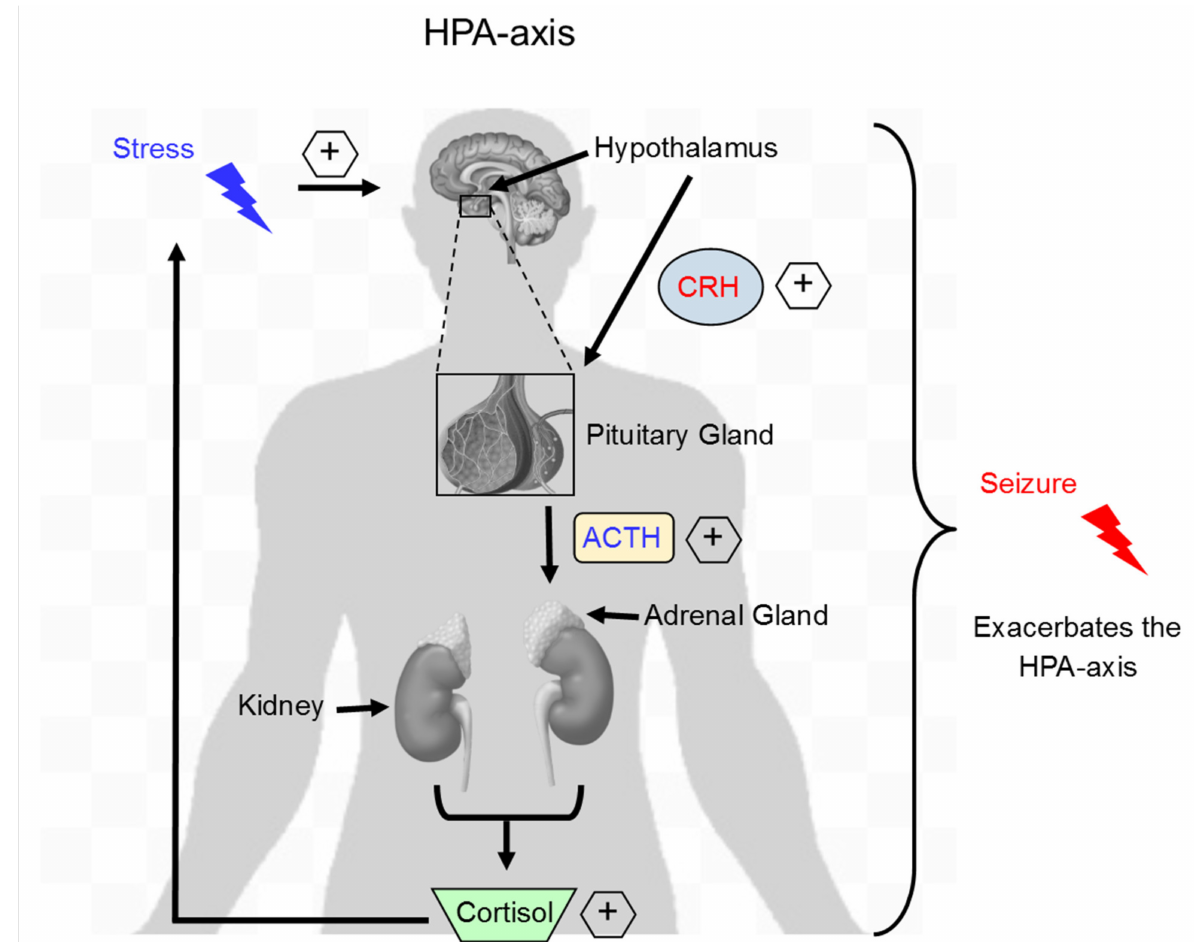
Figure 1. Stress activates the HPA-axis and exacerbates seizure occurrence. Exposure to stress results in hypothalamic release of CRH, which binds its receptors located on the pituitary gland and then subsequent release of ACTH. ACTH binds to receptors located on the adrenal gland and stimulates adrenal release of the stress hormone cortisol. During acute stress, cortisol exerts a negative feedback to CRH and ACTH release. In contrast, during chronic stress, increased cortisol levels persist leading to sustained HPA-axis activation. During a subsequent insult, such as a seizure, activation of the HPA-axis is exacerbated and contributes to future seizure susceptibility and worsened outcomes. HPA, hypothalamus-pituitary-adrenal axis; CRH, corticotropin-releasing hormone; ACTH, adrenocorticotropic